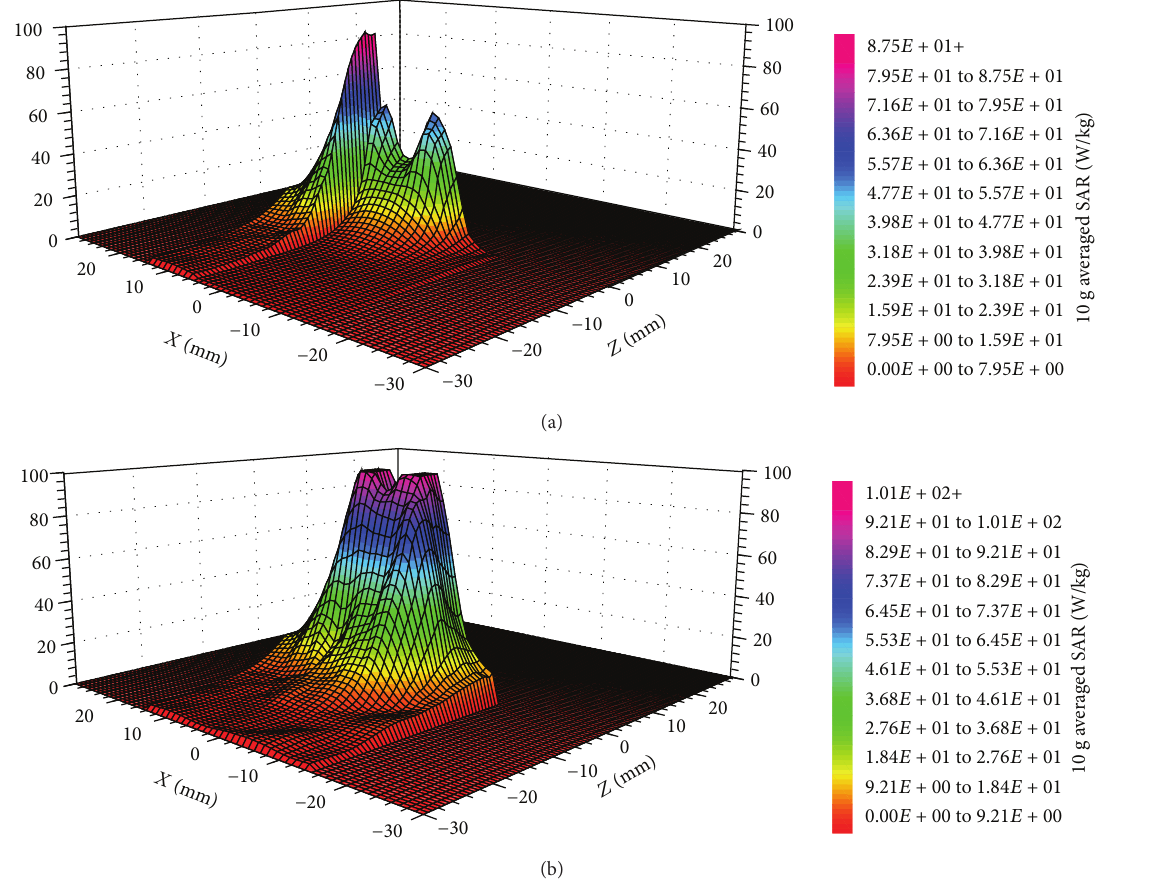
Figure 10: Simulated 10g averaged SAR of the proposed antenna: (a) 2.4 GHz; (b) 5.8